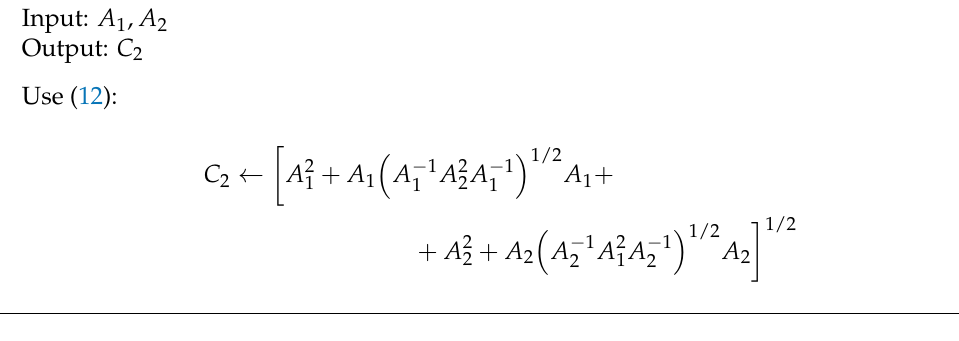
Algorithm A6 Function: Compute the John’s inner bound